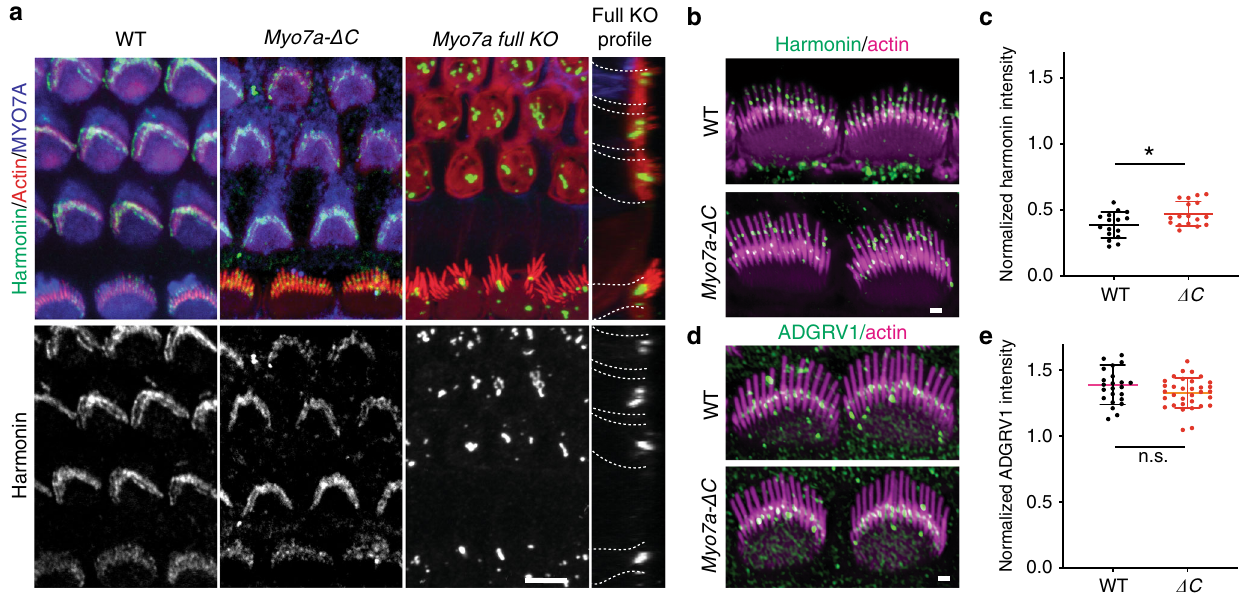
Fig. 5 Harmonin and ADGRV1 localization at the UTLD and the stereocilia base are not decreased in Myo7a- Δ C mice. a WT and Myo7a- Δ C organ of Corti immunostained for harmonin, F-actin, and MYO7A. Harmonin staining was indistinguishable between WT and Myo7a- Δ C, while severe mislocalization (formation of aggregates in the cuticular plate) was observed in Myo7a full KO mice (scale bar: 10 μ m). b , c Harmonin immunoreactivity at the UTLDs in WT and Myo7a- Δ C IHCs at P7. Compared with WT, harmonin signal is slightly increased at the UTLD of Myo7a- Δ C IHCs. For quanti fi cation, harmonin fl uorescence intensities in stereocilia (UTLDs of longest stereocilia only) were measured using ImageJ, normalized to phalloidin reactivity at the same site, and a mean intensity determined for each cell. Normalized harmonin intensities (mean ± SD): WT = 0.40 ± 0.092, Myo7a- Δ C = 0.47± 0.093, p = 2.34e − 2 (two-tailed, unpaired t -tests). N = number of cells. Analyzed numbers (UTLDs; cells; animals): WT (167; 16; 3), Myo7a- Δ C (209; 17; 4) (scale bar: 1 μ m). d , e ADGRV1 immunoreactivity at the stereocilia base was not signi fi cantly changed in Myo7a- Δ C IHCs at P7 compared with WT. ADGRV1 immuno fl uorescence intensity (from middle cochlear region) was determined for each cell and normalized to background immuno fl uorescence in the cuticular plate region of the same cell. Normalized ADGRV1 intensities (mean ± SD): WT = 1.39 ± 0.49, Myo7a- Δ C = 1.32 ± 0.16, p = 0.08 (two-tailed, unpaired t -tests). N = number of cells. Analyzed numbers (cells; animals): WT (24; 7), Myo7a- Δ C (33; 7) (scale bar: 1 μ m). Data are plotted as mean ± SD. Source data are provided in the Source Data fi